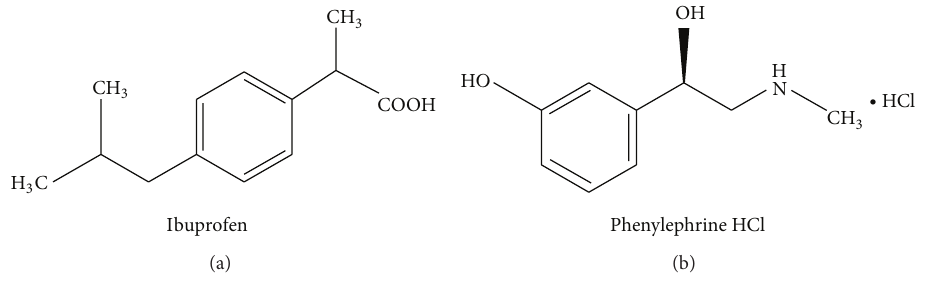
Figure 1: Chemical structure of (a) IBU and (b) PHE.